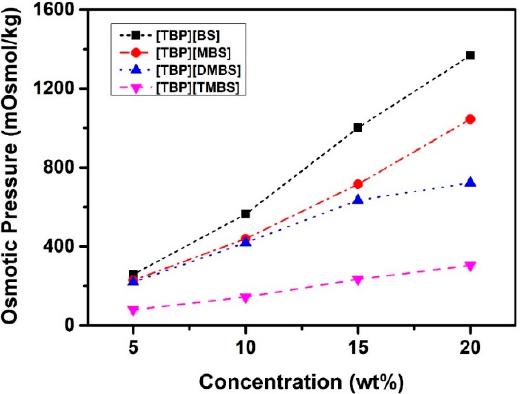
Figure 6. Osmotic pressure according to the concentration of [TBP][BS], [TBP][MBS], [TBP][DMBS], and [TBP][TMBS] measured by the freezing point depression method.